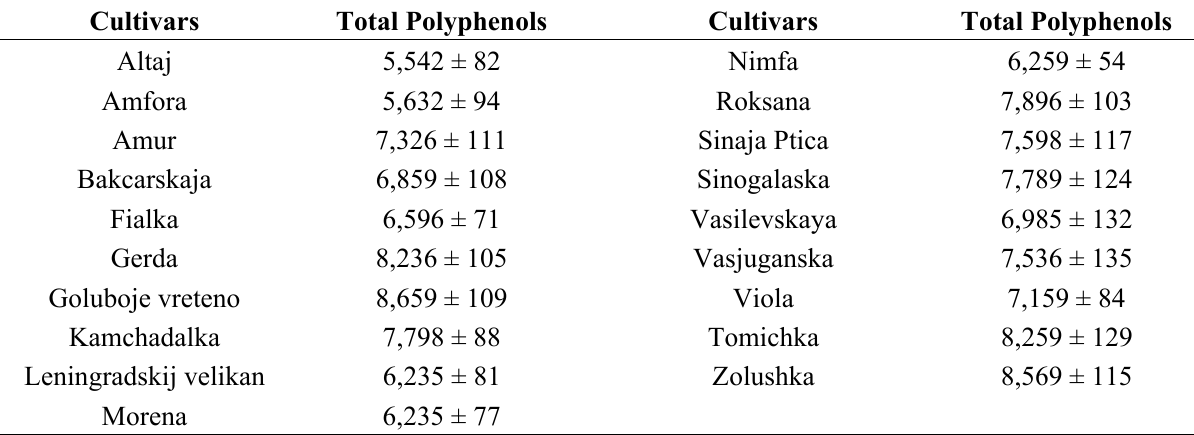
Table 1. The values of the total polyphenolic content in observed cultivars of honeysuckle. Results are given in mg/kg equivalent of gallic acid